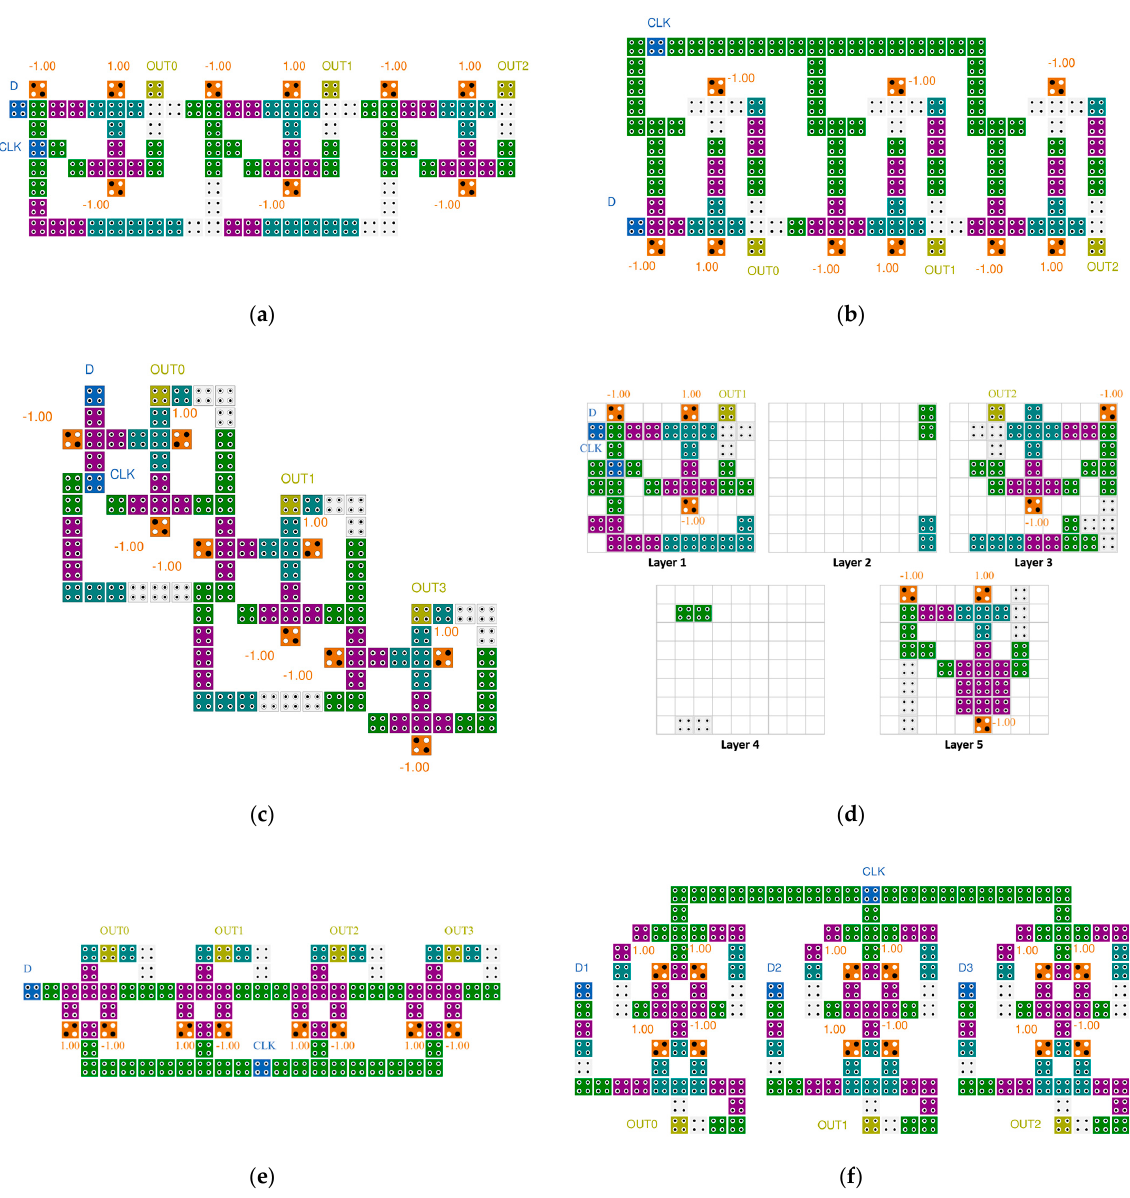
Figure 7. Typical 3~4 bit SRs: ( a ) J. C. Das’s [28]; ( b ) M. N. Divshali et al.’s [29]; ( c ) M. Abdullah-Al- Shafi et al.’s [30]; ( d ) T. Li et al.’s [31]; ( e ) M. G. Roshan et al.’s [32]; and ( f ) S. Fan et al.’s [33].